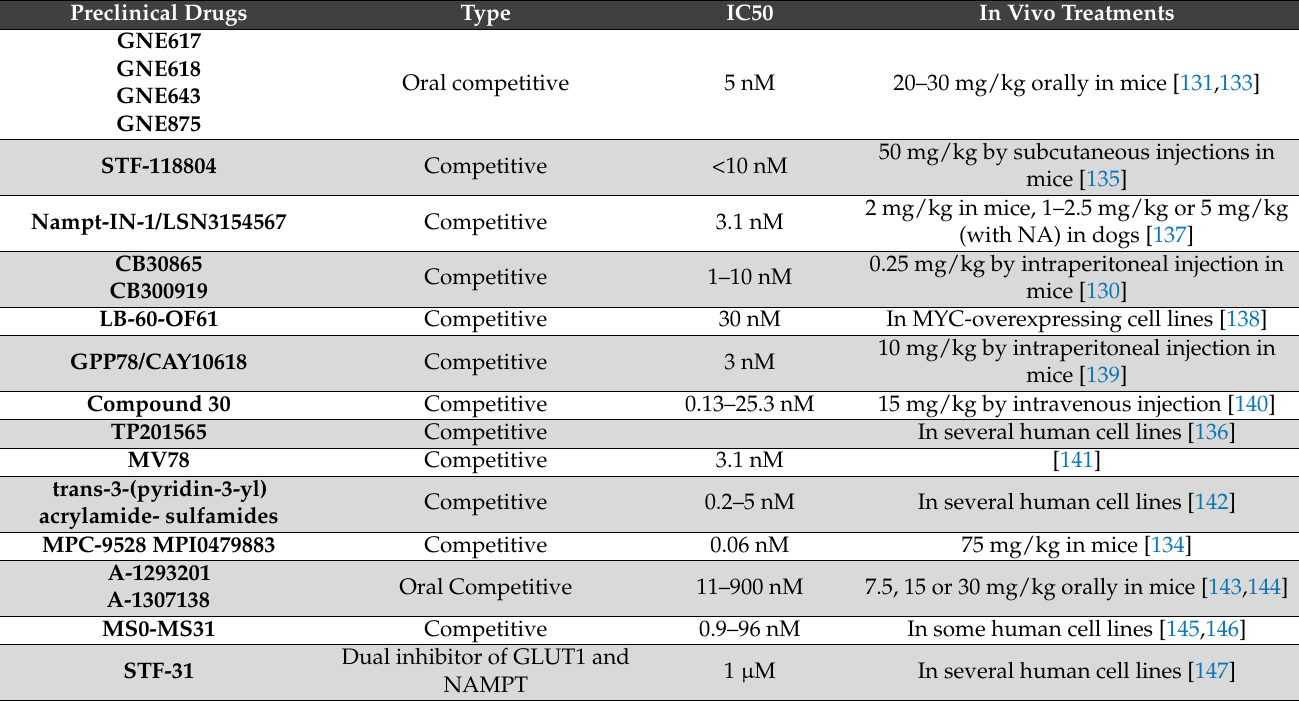
Table 2. NAMPT inhibitors in preclinical